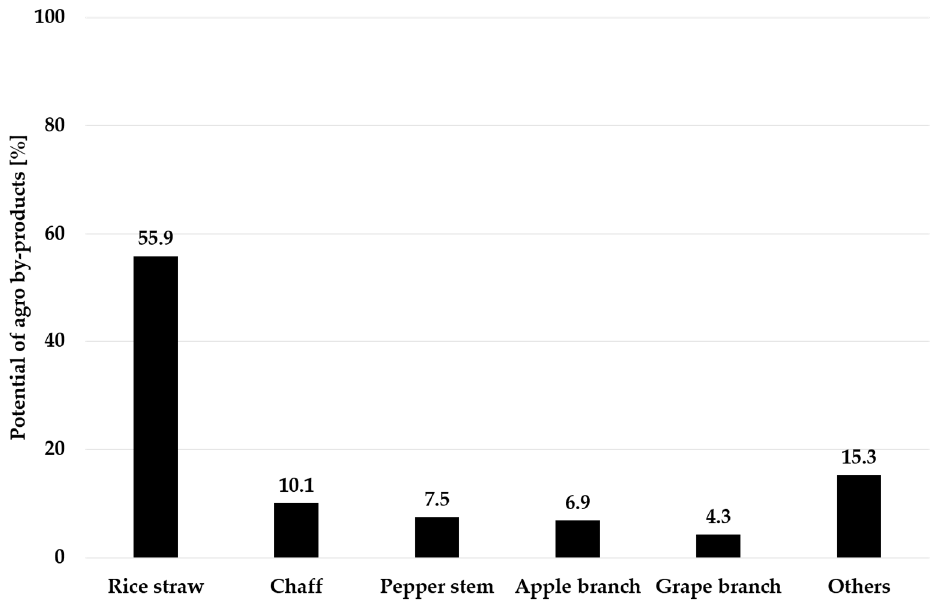
Figure 1. Estimation of geographical and technical potential of biomass resources [1].